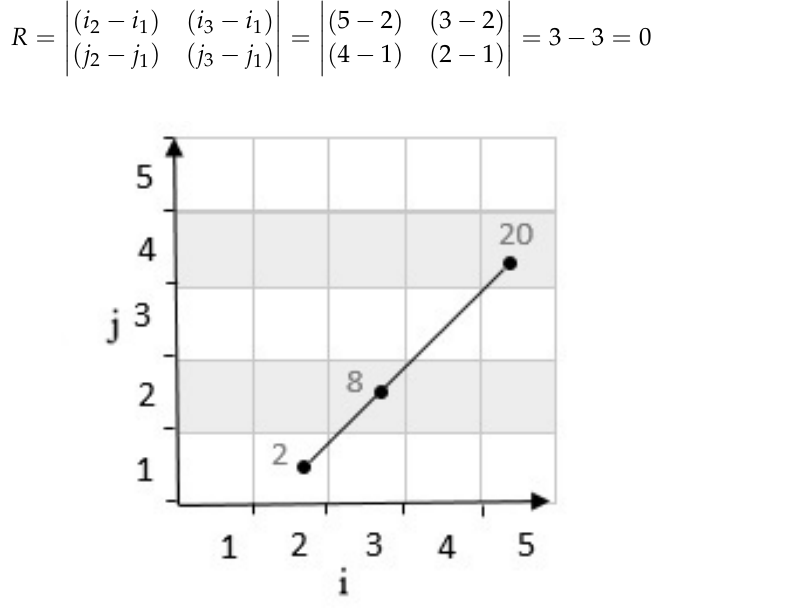
Figure 8. Position of a point with neutral